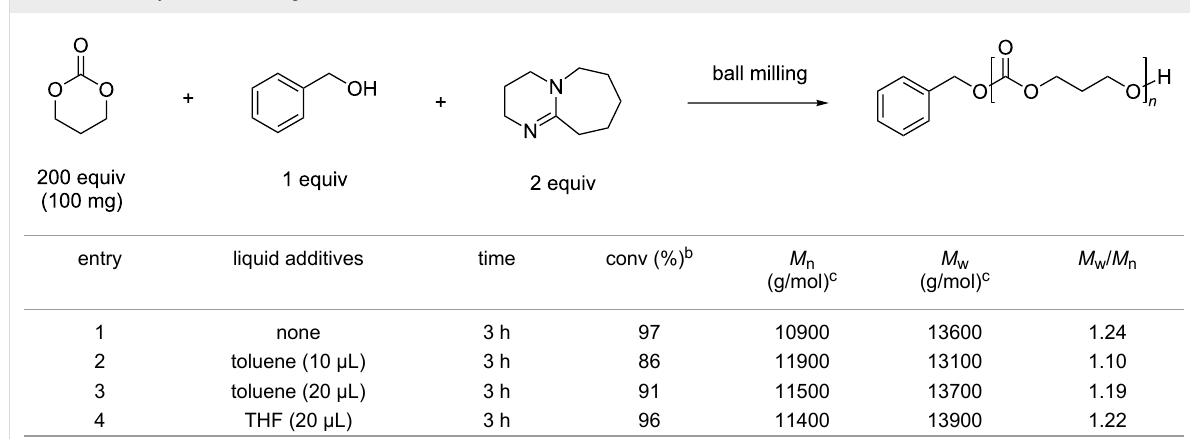
Table 5: PTMC synthesis with a high monomer to initiator ratio.